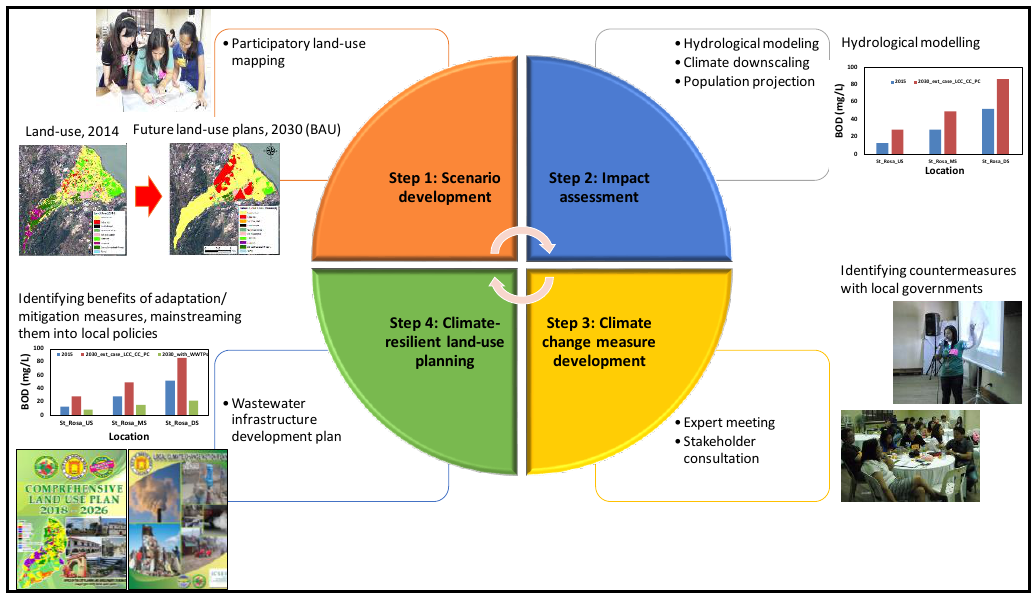
Figure 2. Research methodology.